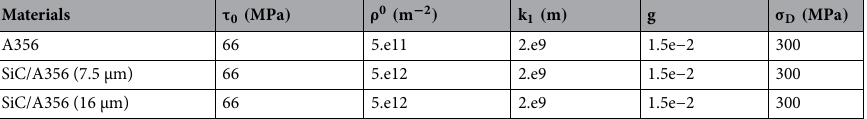
Table 1. The dislocation density hardening parameters of the A356 matrix and the 15 vol.% SiC/A356 composites.